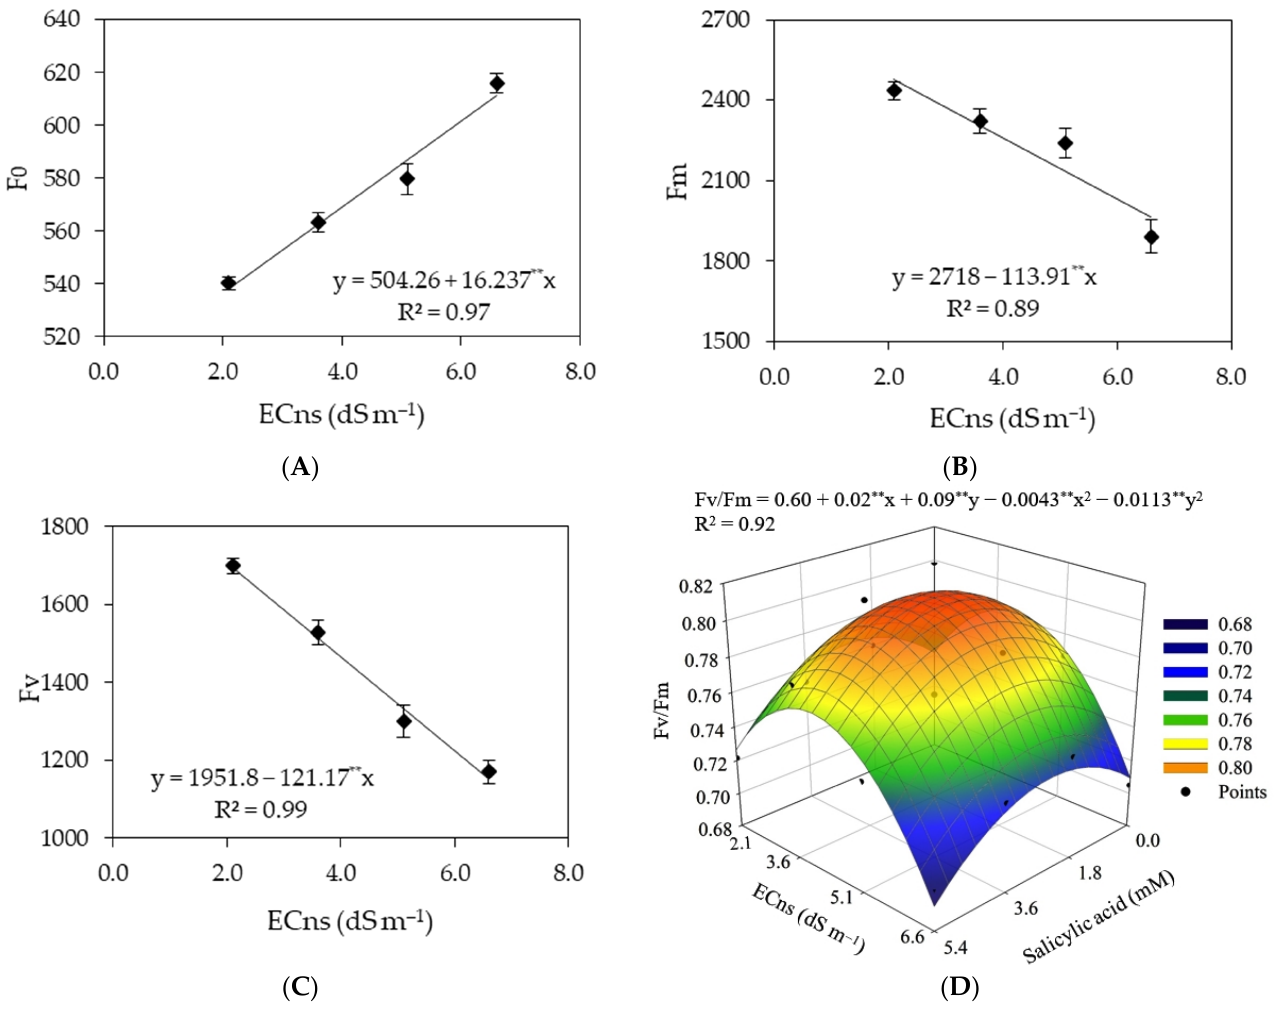
Figure 7. Initial fluorescence—F0 ( A ), maximum fluorescence—Fm ( B ), and variable fluorescence—Fv ( C ) as a function of electrical conductivity of the nutrient solution (ECns) and response surface for the quantum efficiency of photosystem II—Fv/Fm ( D ) of Japanese cucumber as a function of the interaction between ECns and the concentrations of salicylic acid (SA), grown in a hydroponic system, 40 days after transplanting. X and Y—concentration of SA and ECns, respectively; ** significant at p ≤ 0.01. Vertical lines represent the standard error of the mean ( n = 4).